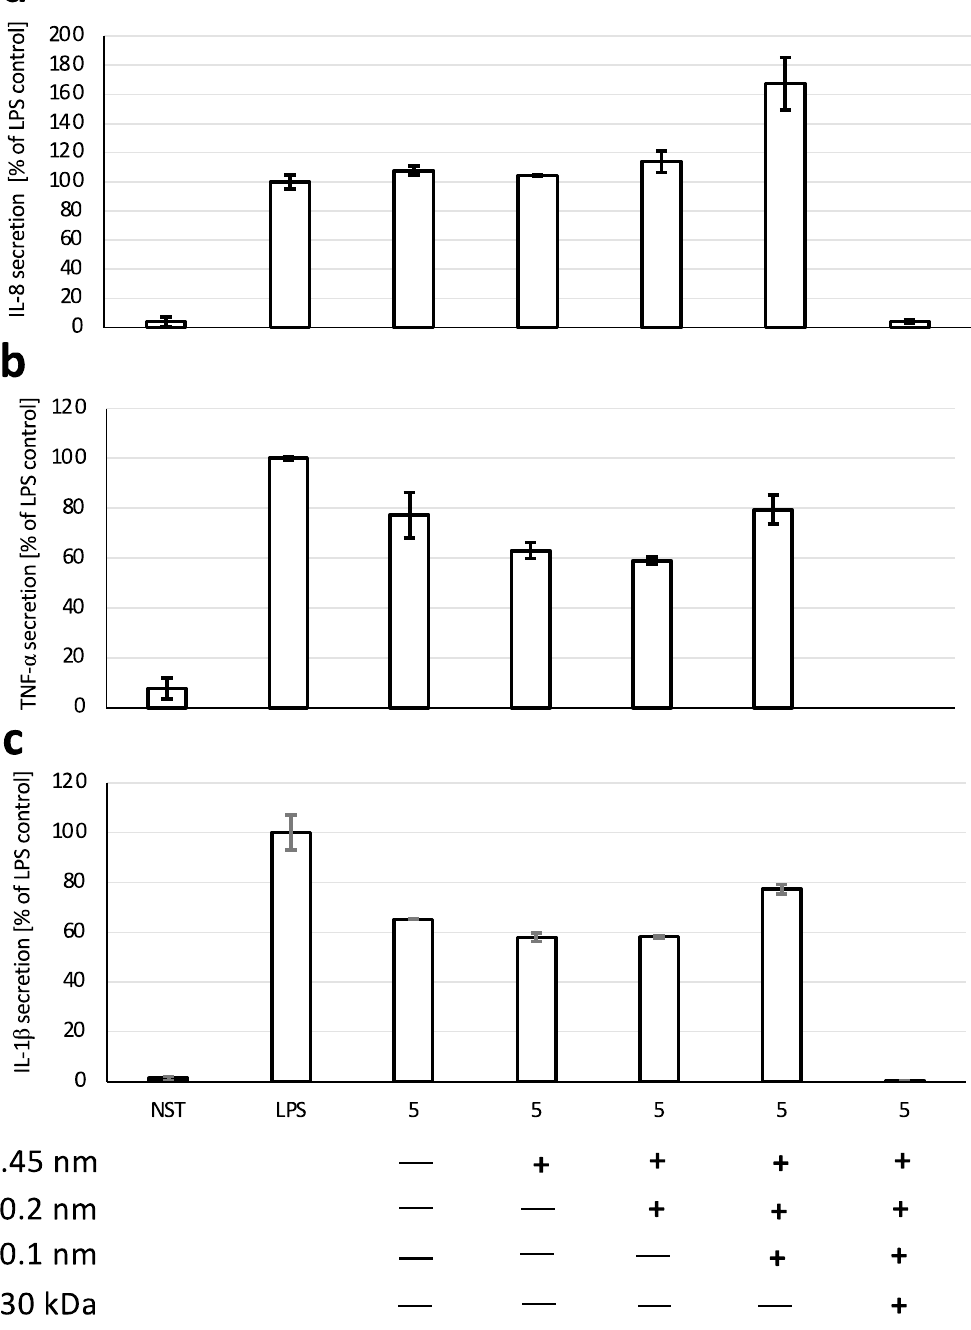
Figure 5. Influence of subsequent filtration steps on extract 5 (50 μg/mL) stimulatory properties towards secretion of IL-8 ( a ), TNF-α ( b ), IL-1β ( c ) by neutrophils. Data were expressed as mean ± SEM of three separate experiments conducted in triplicate. The experiments were performed with cells isolated from three independent